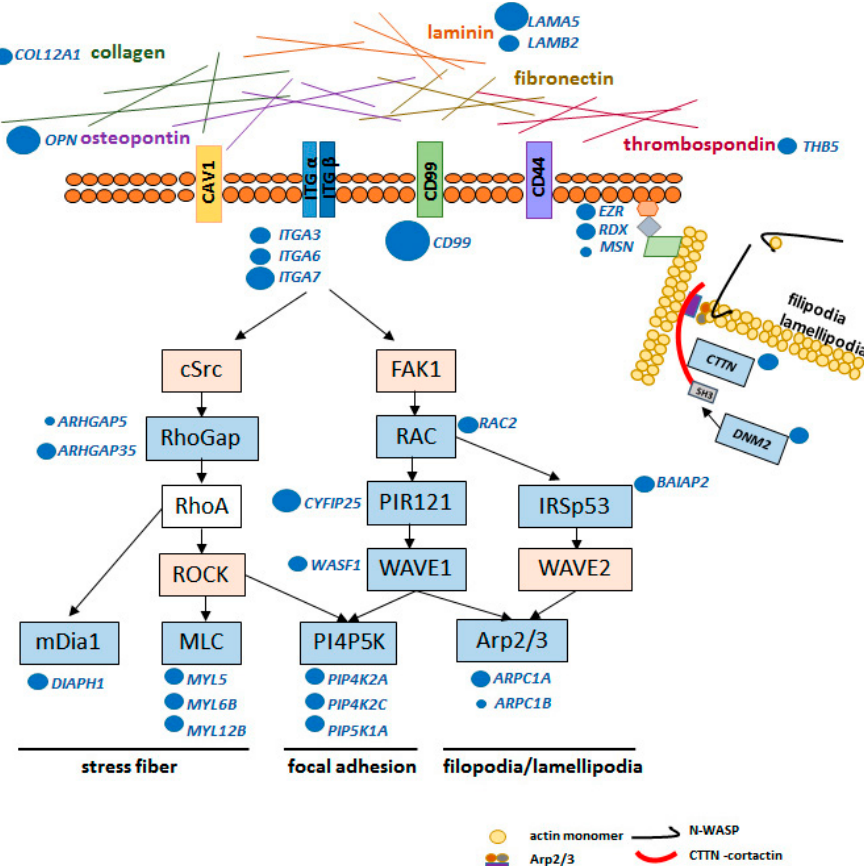
Figure 5. Schematic representation of the focal adhesion and actin regulation of cytoskeleton pathways, showing the plasma membrane and extracellular matrix target, and downstream pathways through c-Src and FAK1 with corresponding intermediate targets involved in stress fiber formation, focal adhesion, filopodia and lamellipodia formation. The gene symbol or the symbol for a group of genes are represented by a blue rectangle when downregulated or an orange rectangle when upregulated, according to the CD99 -siRNA U87MG transcriptome analysis. The specific downregulated genes of each group are annotated next to the corresponding rectangle, and the size of blue juxtaposed circles is proportional to RNA-Seq fold change. Below the plasma membrane, on right side, the ERM complex (ezrin-radixin-moesin, coded by EZR , RDX and MSC , respectively) is represented linked to actin polymer, and at the actin branching site, Arp2/3 complex—cortactin ( CTTN )—N-WASP—dynamin 2 ( DNM2 ) are represented in lamellipodia and filopodia formation. All components were downregulated when CD99 was silenced, demonstrating their role in the reduction of cell migration.